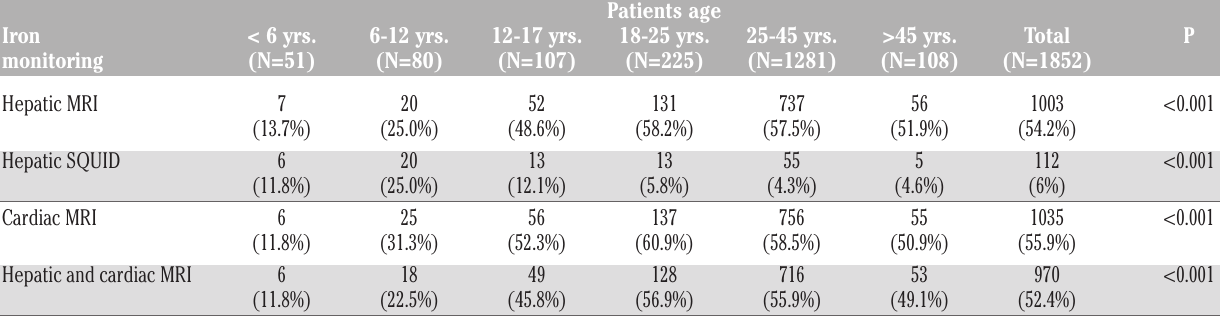
Table 4. Instrumental Iron Overload monitoring by